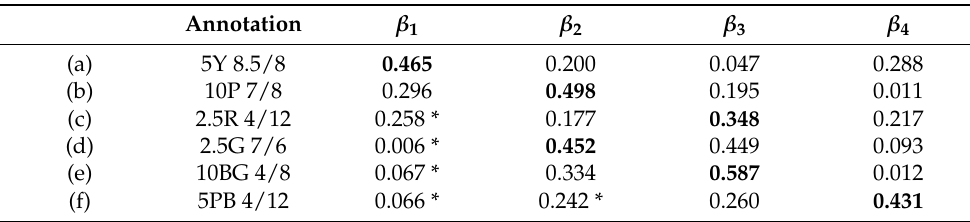
Table 1. Munsell annotation of color chip and the β k value in Equation (13) for the cases shown in Figure 10a–f. The maximum β k value is shown in bold. The β k value corresponding to the normalized ARS neighborhood is indicated with